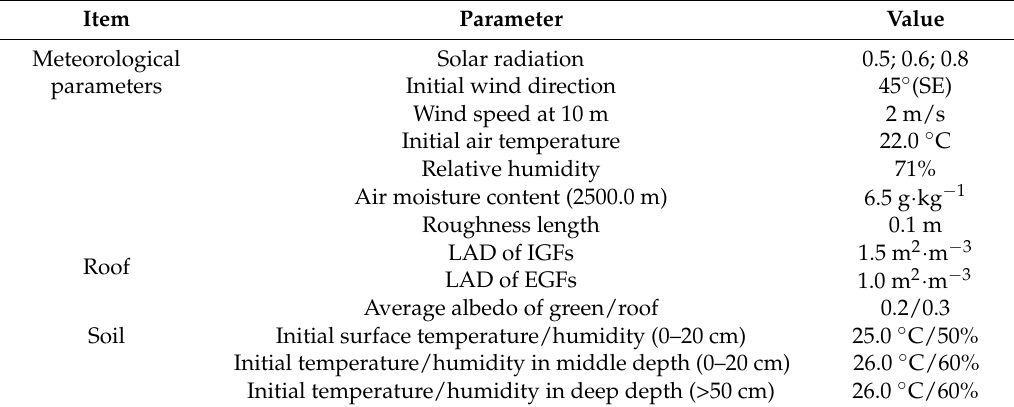
Table 2. Settings of boundary condition in verified ENVI-met